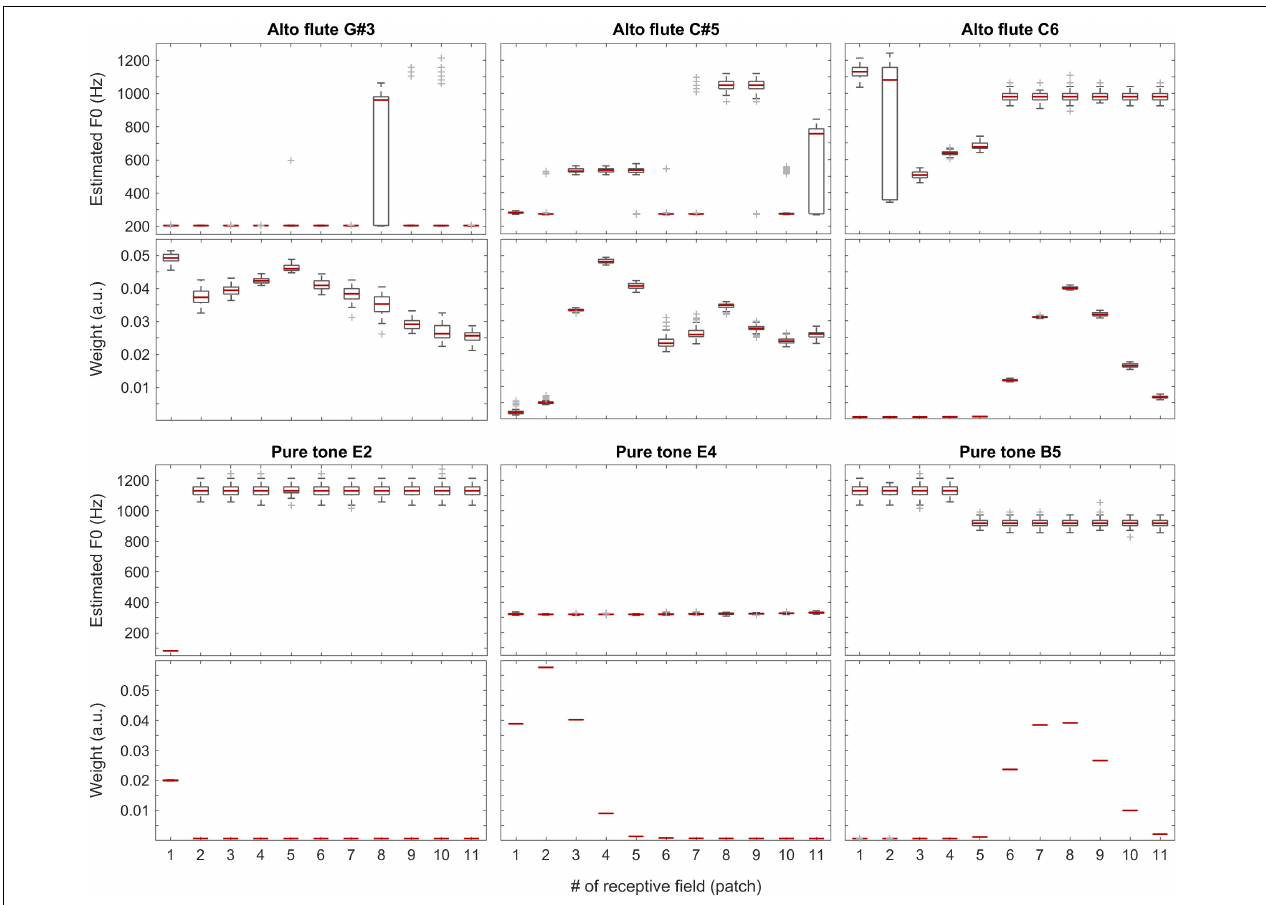
FIGURE 10 | F0 estimates (first and third rows) and weights (second and fourth rows) for all patches over all 100 iterations for the alto flute recordings (top two rows) and pure tones (bottom two rows).